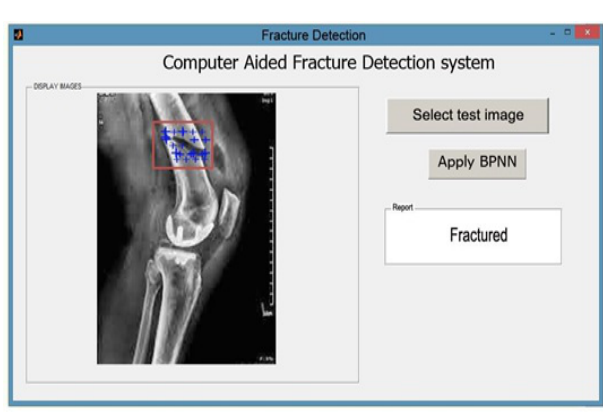
Figure 7. GUI of the proposed fracture detection system